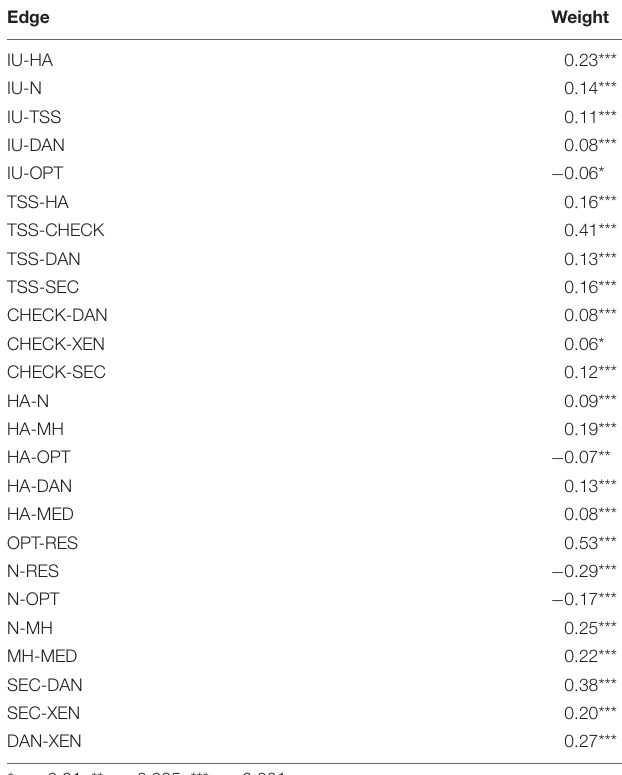
TABLE 2 | Edge weights (regularized partial correlations) between nodes in the